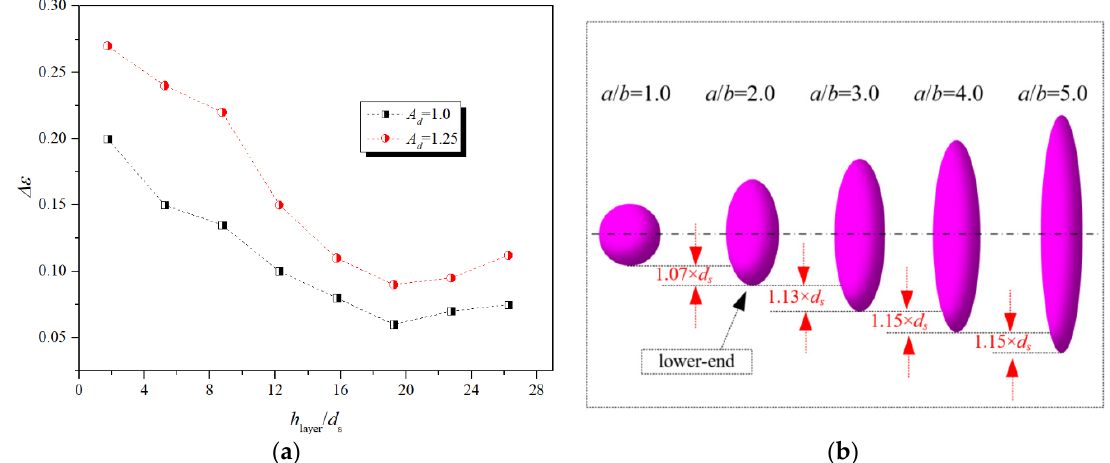
Figure 6. ( a ) ∆ ε varies with bed layer; ( b ) a schematic of intruders with different aspect ratios.